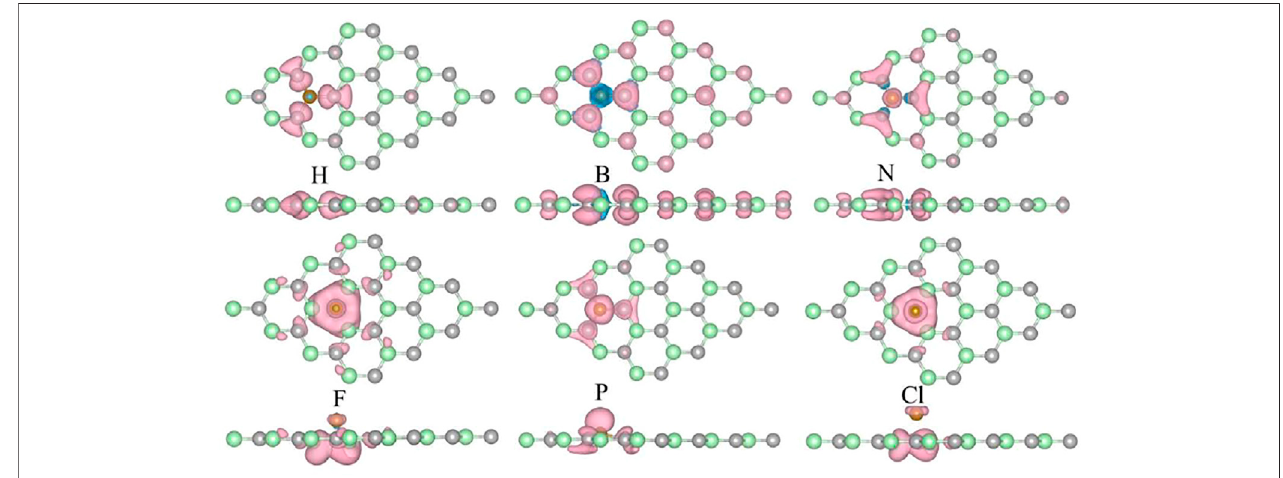
FIGURE 3 | The spin-polarized charge density of the metal-doped SiC system. The pink and blue areas represent the contribution of the spin-up, and the spin- down components, respectively. The isovalue is set to 0.001 e/Å 3 .